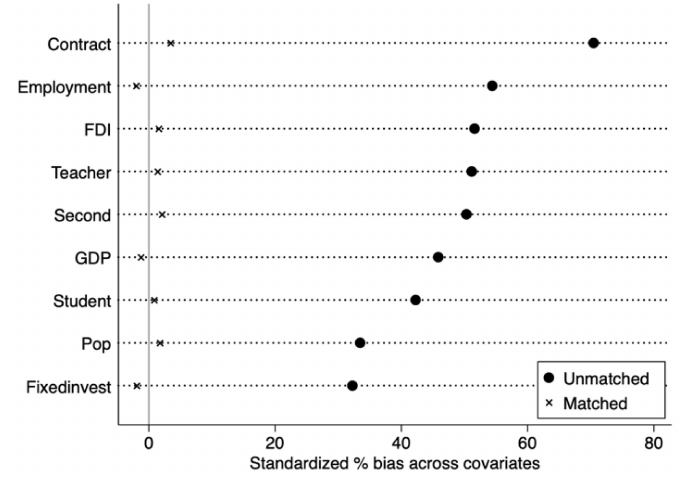
Figure 2. City characteristic bias before and after matching.